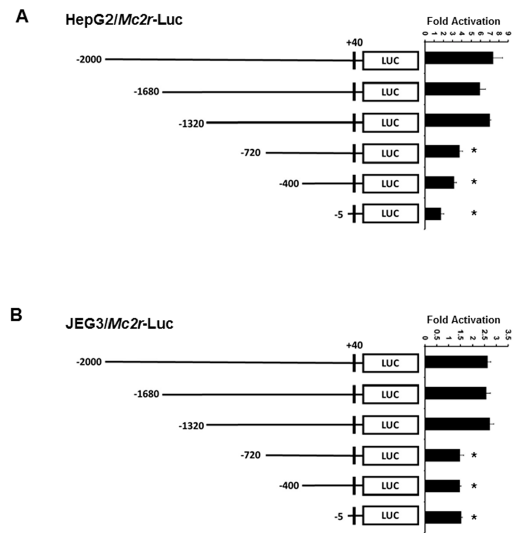
Figure 3. Regions of Mc2r promoter important for transcriptional activation by JDP2. HepG2 ( A ) and JEG3 ( B ) cells were co-transfected with mouse Mc2r promoter deletion constructs and Jdp2 expression plasmid. Luciferase activities were measured 48 h after transfection and normalized with Renilla activity. Relative LUC activity (fold activation) was calculated and plotted. The experiments were performed three times in triplicate. Error bars indicate the standard error. * indicates two-tailed t test p < 0.05 vs. − 2000-bp construct. Int. J. Mol. Sci. 2017 , 18 , 304